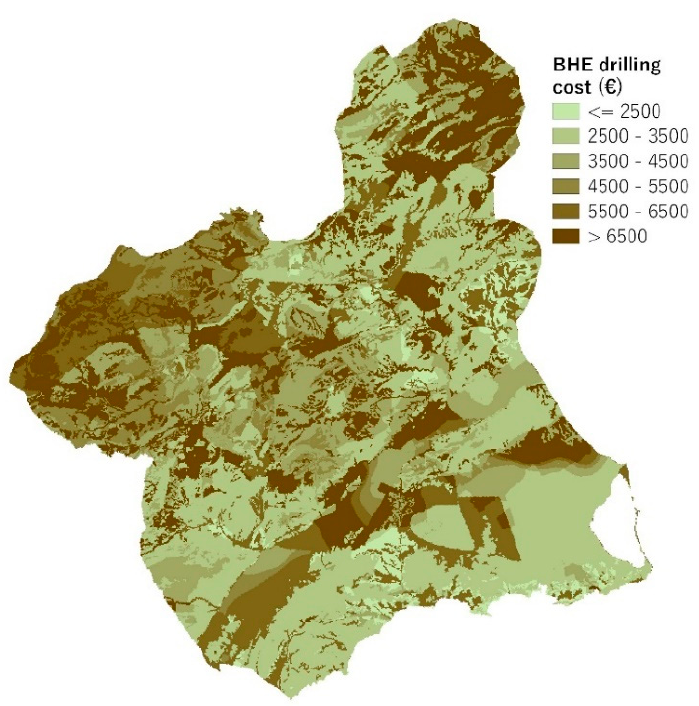
Figure 10. Drilling costs map. Costs are calculated on the basis of the BHE length required.